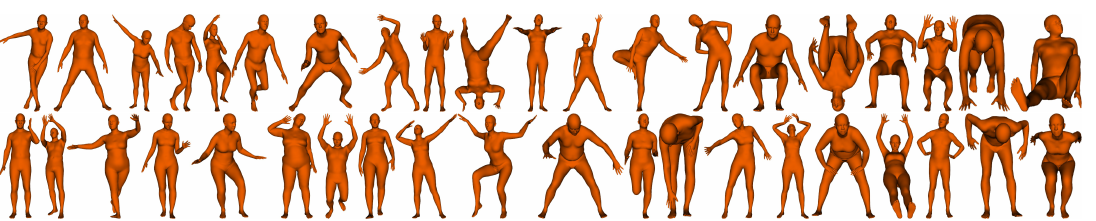
Figure 9. Fifteen representative poses in the FAUST dataset [4], where the blue rectangle regions contain large missing parts.